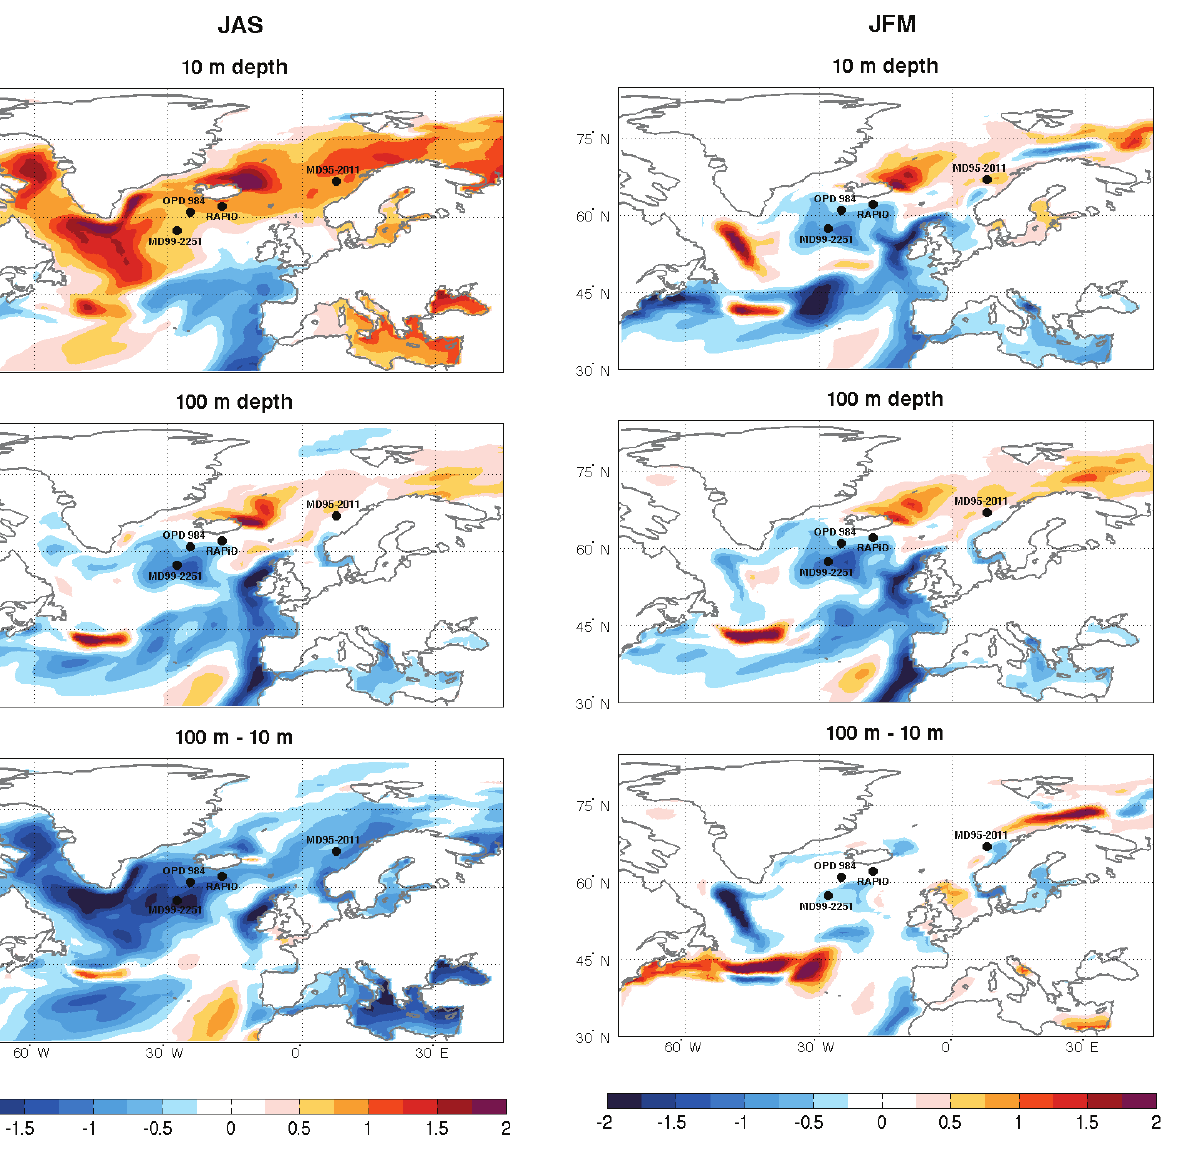
Fig. 9. Ocean potential temperature differences between MH and PI in CCSM3 for summer (JAS) at 10m depth (upper panel) and 100m depth (center). The lower panel shows the MH-PI anomaly for the difference between 100m and 10m depth.